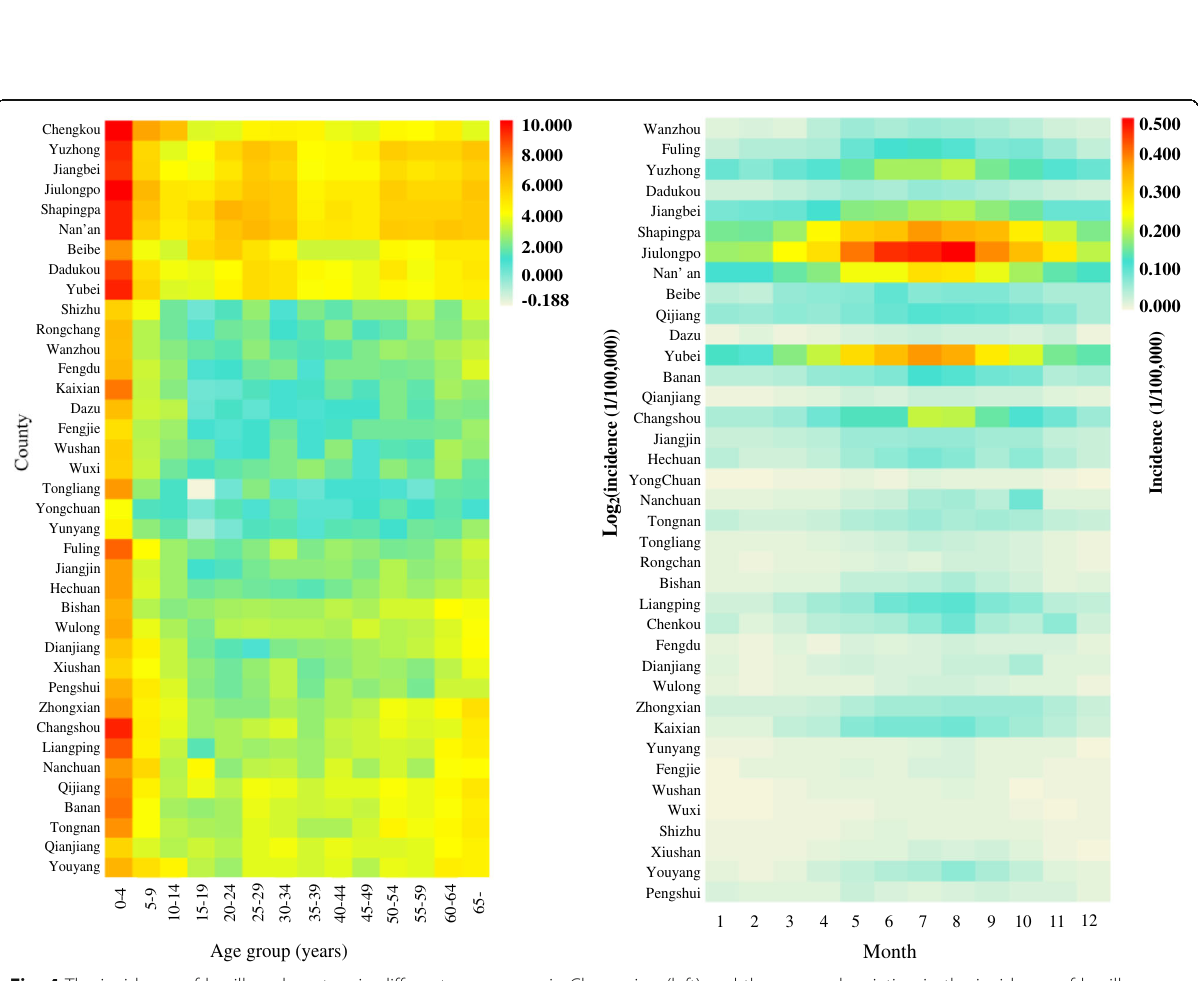
0.4000.500 0.300